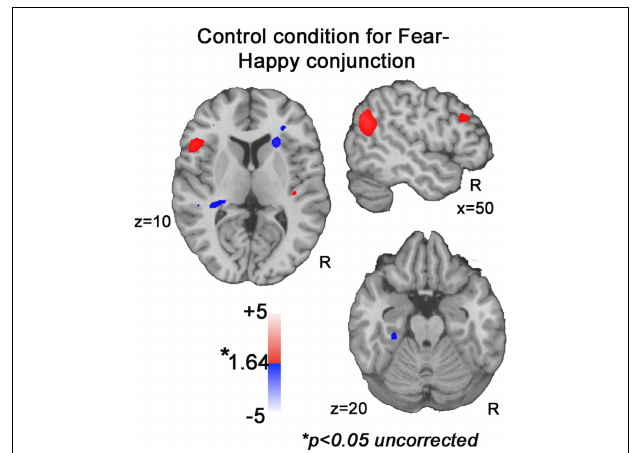
FIGURE 7 | Control conjunction analyses. Increasing or decreasing F0 across fear and happiness does not reveal activation in STG, IFG or amygdala at uncorrected p < 0.05